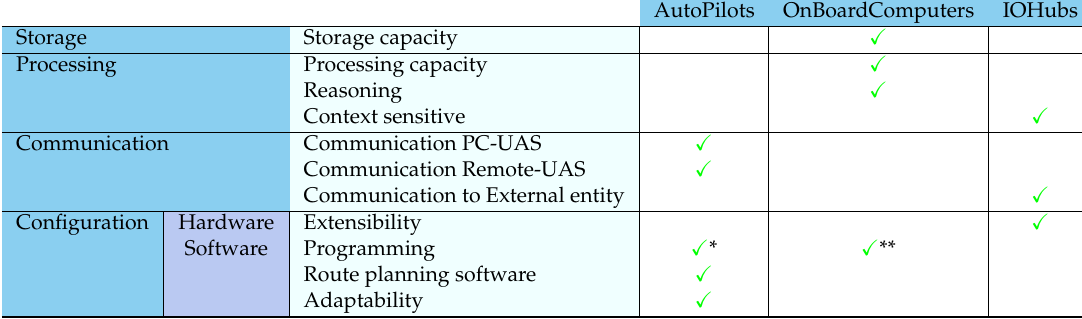
Table 6. Features provided by each